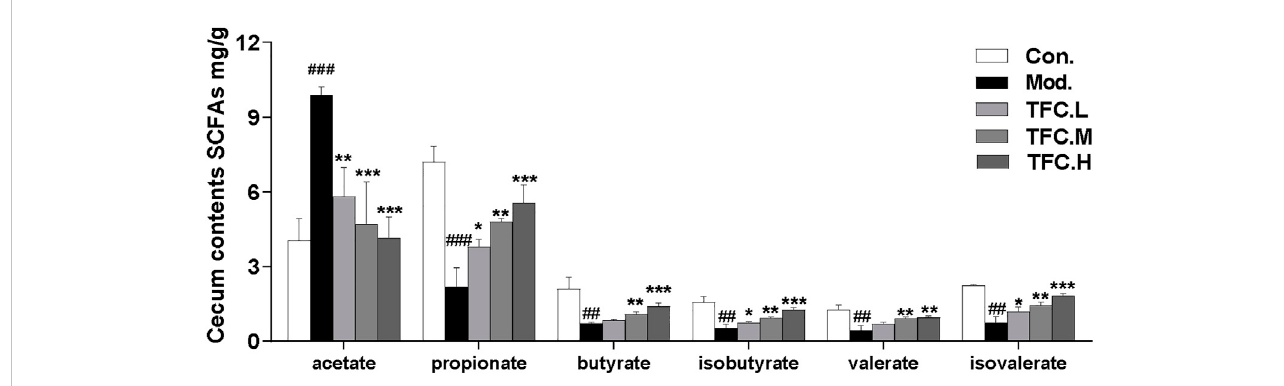
FIGURE 8 ContentofSCFAsincecumcontents.Thedataareexpressedasthemeans±SD.Dataareexpressedasmean±S.D. # p < 0.05, ## p < 0.01, ### p <